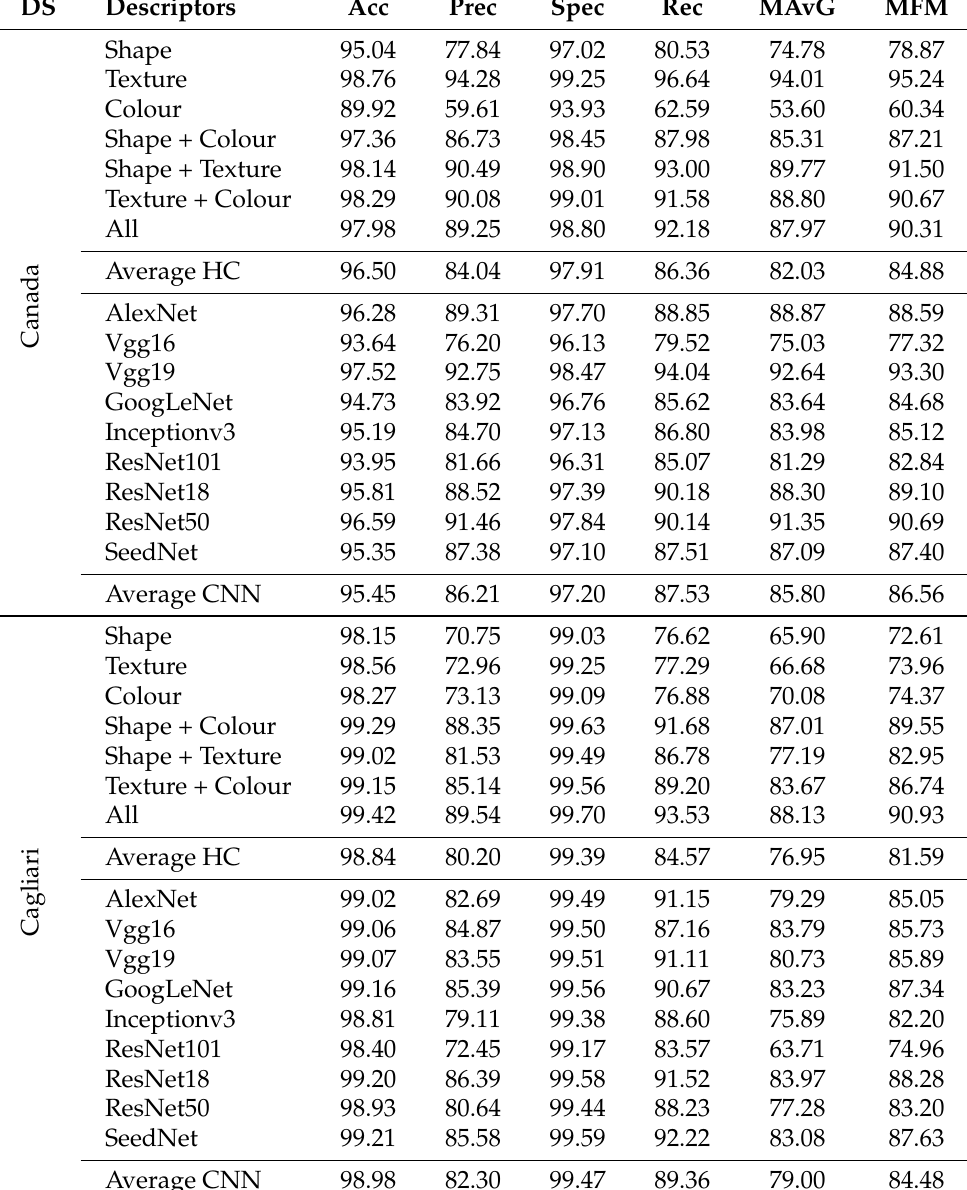
Table A5. Performance results attained using HC descriptors and deep features by Ensemble classifier on Canada and Cagliari data sets. The ensemble was trained with a bag method and tree as a learner. DS indicates the data